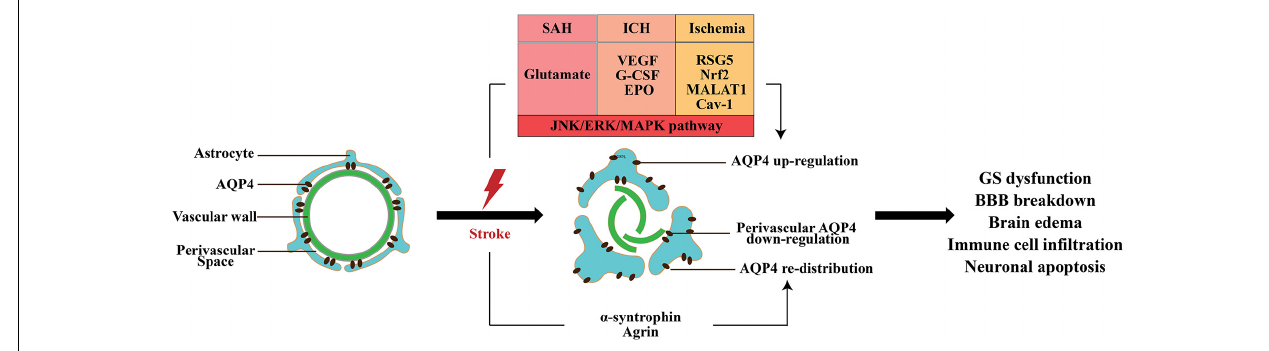
FIGURE 3 | The change in AQP4 expression after stroke. AQP4 mislocalization and an increase in total AQP4 expression appear in all subtypes of stroke; however, the perivascular polarity of AQP4 decreased. The matrix constituent agrin and α -syntrophin play an important role in anchoring of AQP4 to astrocytic end-feet. After stroke, multiple factors increase the expression of AQP4, including glutamate VEGF, G-CSF, EPO, RSG5, Nrf2, lncRNA MALAT1, and Cav1. Moreover, activation of MAPK pathway is responsible for AQP4 upregulation. AQP4 mislocalization and expression change are involved in the GS dysfunction, BBB disruption, brain edema, and neuronal apoptosis induced by